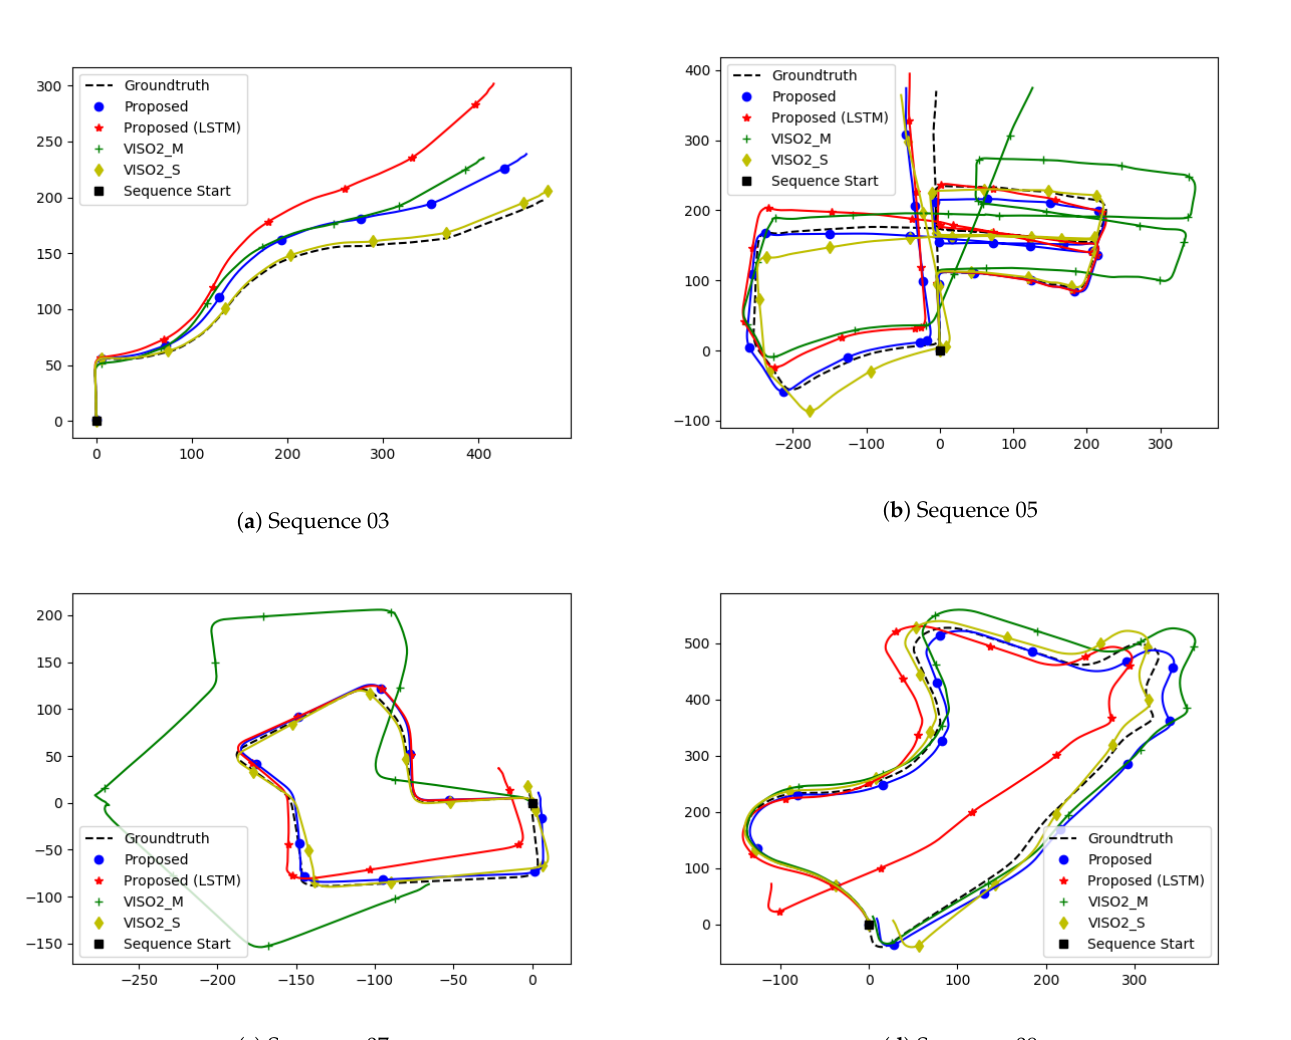
Figure 5. Comparison of our proposed method with